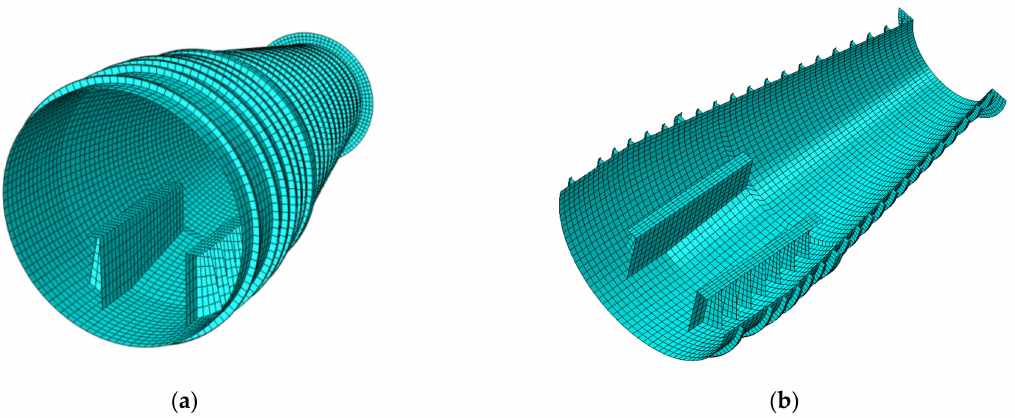
Figure 1. Finite element model of the ring-stiffened conical shell with bases: ( a ) axonometric drawing; ( b ) cutaway view.